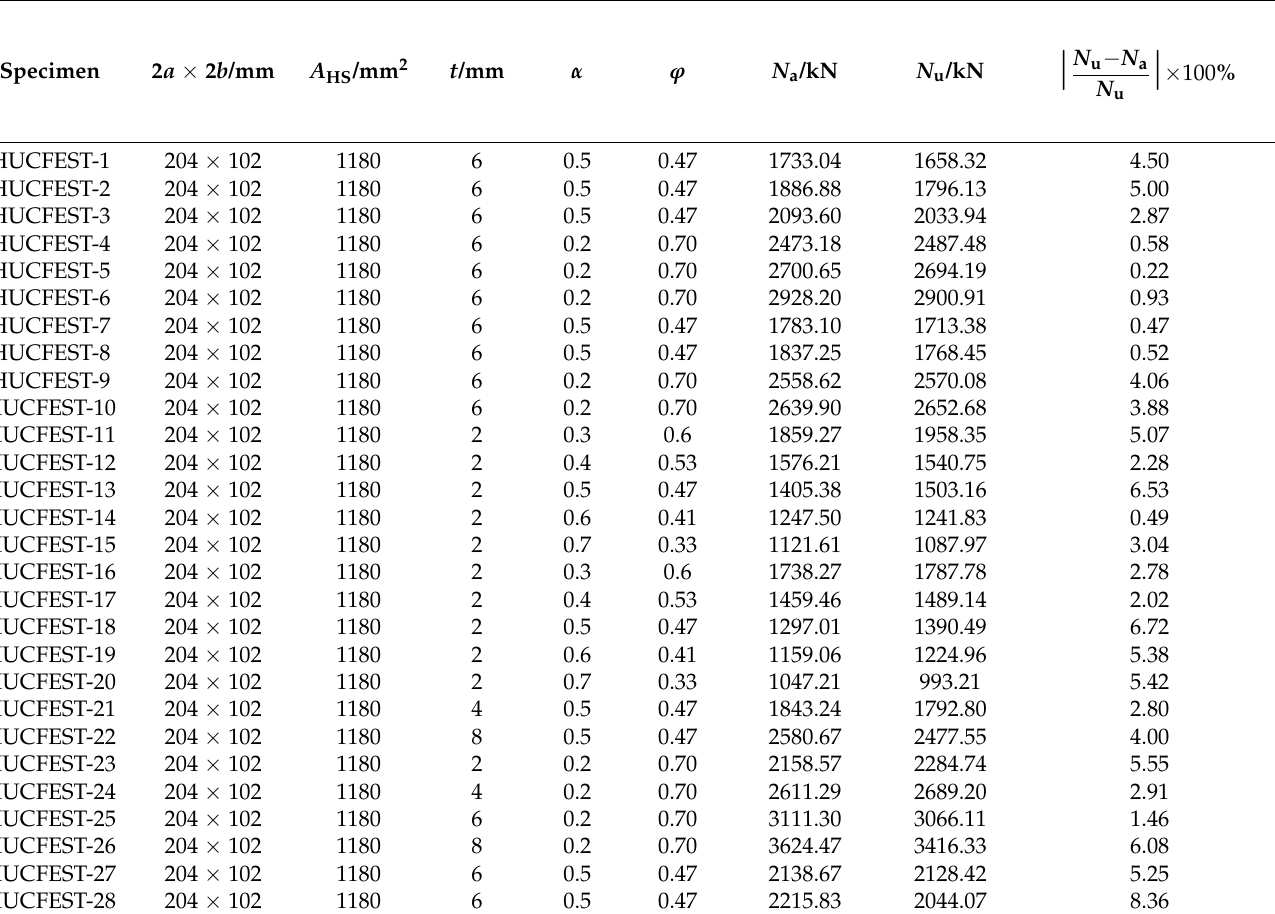
Table 2. Comparison between N a and N u for the 44